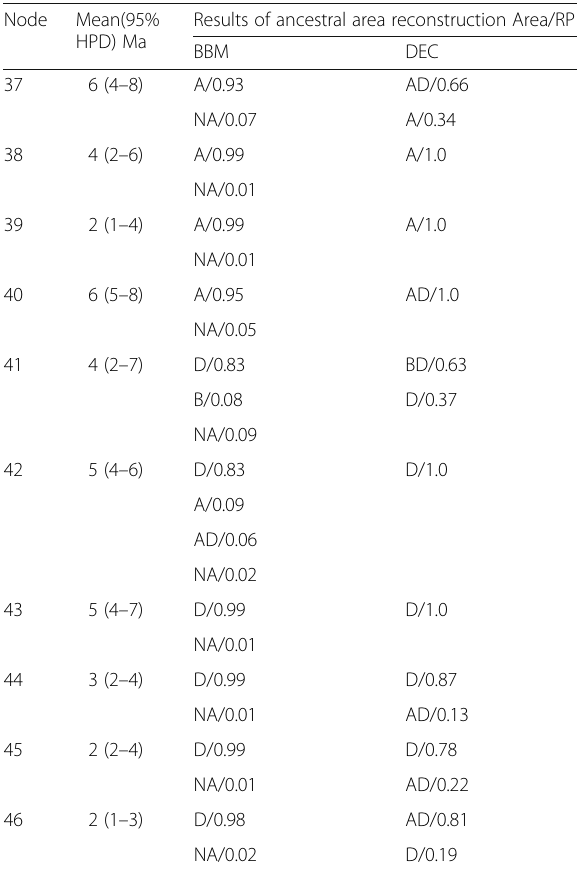
Table 3 Divergence time estimates of BEAST analyses for major nodes of Pleurotus ostreatus species complex